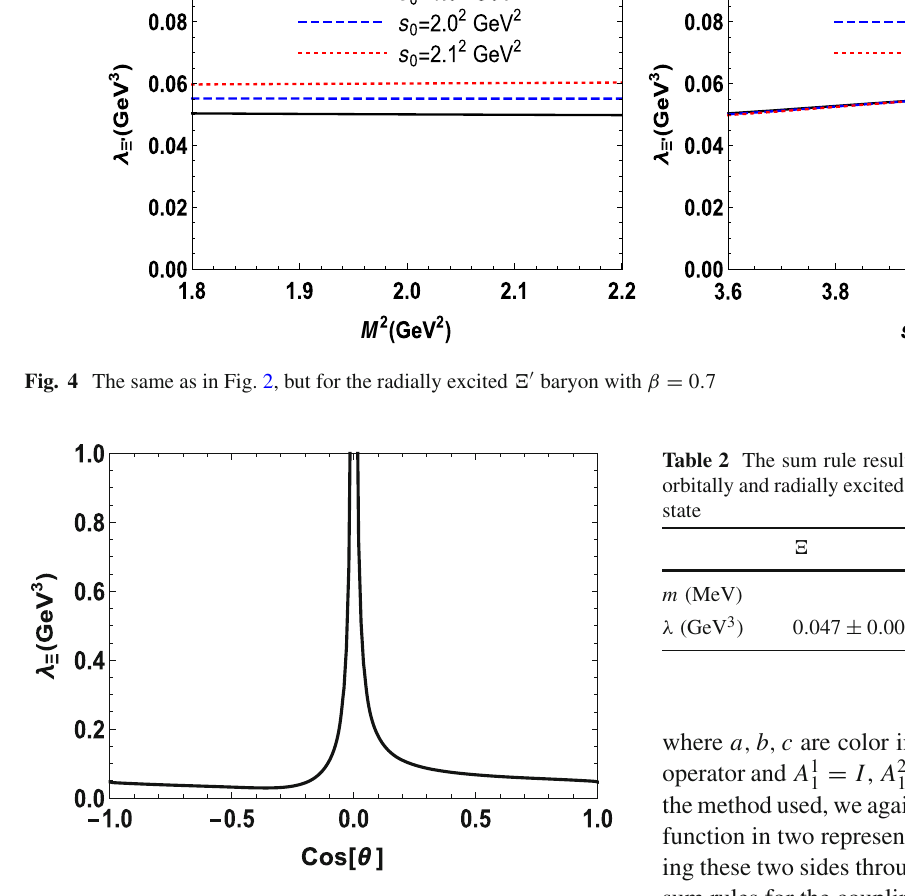
Fig. 5 The residue of the ground state (cid:2) baryon as a function of the cos θ at central values of the s 0 and M 2